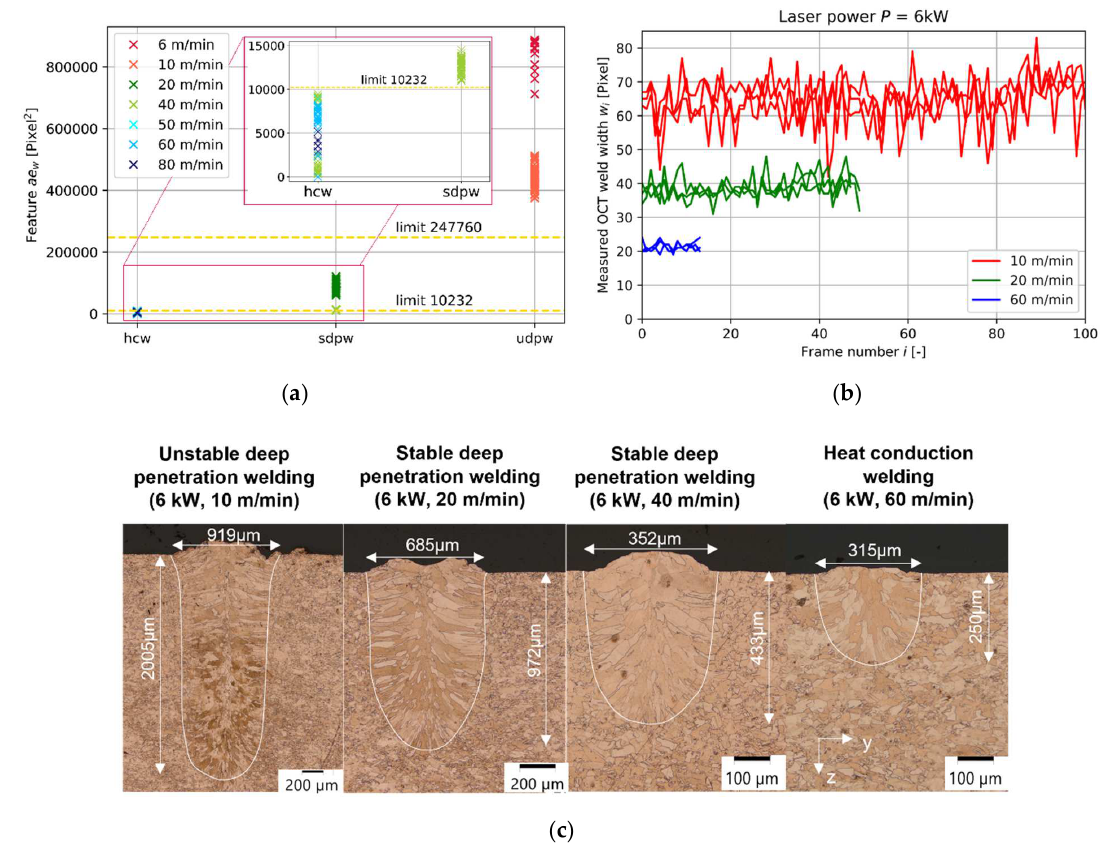
Figure 3. ( a ) Feature value for the three possible welding statuses: heat conduction welding (hcw), stable deep penetration welding (sdpw), and unstable deep penetration welding (udpw). The yellow dotted line indicates identified limits of each welding status; ( b ) Measured OCT weld width in the interaction region over frame number of OCT images for three different welding speeds at a constant laser power of 6 kW. Each speed corresponds to a process regime (hcw, 60 m/min) (sdpw, 20 m/min) (udpw, 10 m/min); ( c ) Metallographic cross-sections for four different welding speeds at a constant power of 6 kW.